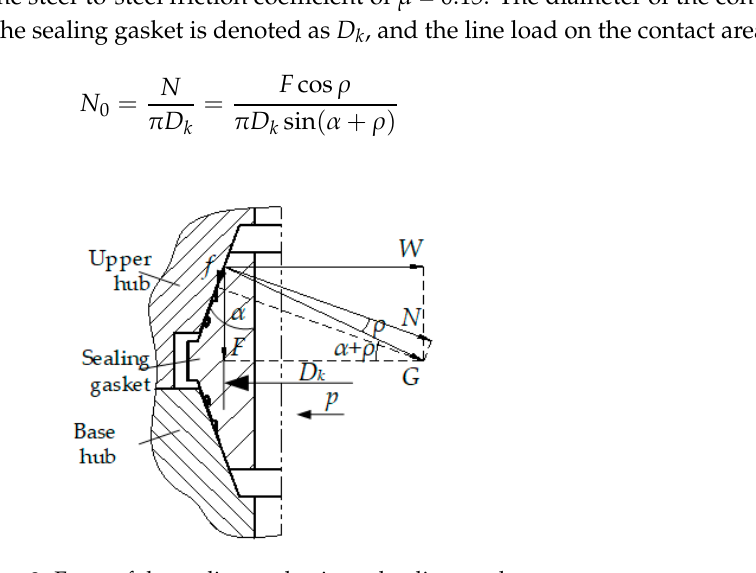
Figure 3. Force of the sealing gasket in preloading mode.